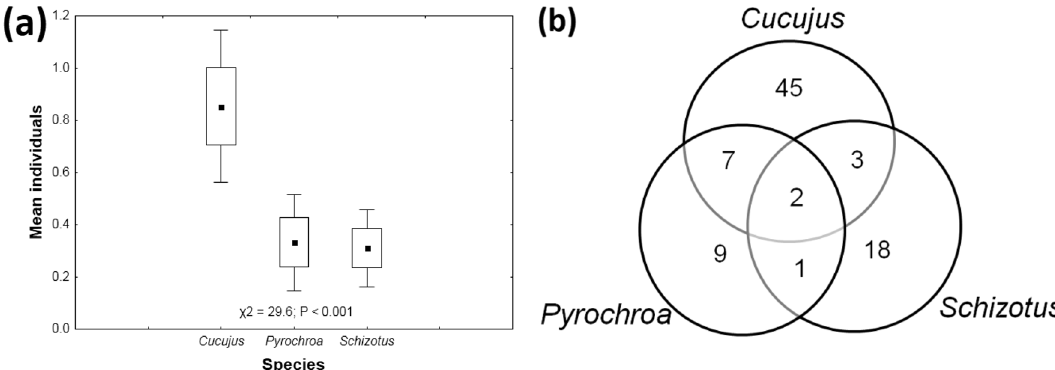
Figure 2. ( a ) Comparison of larval abundances among the three studied saproxylic beetles in the Czech Republic. Squares are the means; boxes are the means ± SEs; and whiskers are the means ± 1.96 SEs. ( b ) Venn diagram illustrating the numbers of observed occurrences and cooccurrences of the studied species.